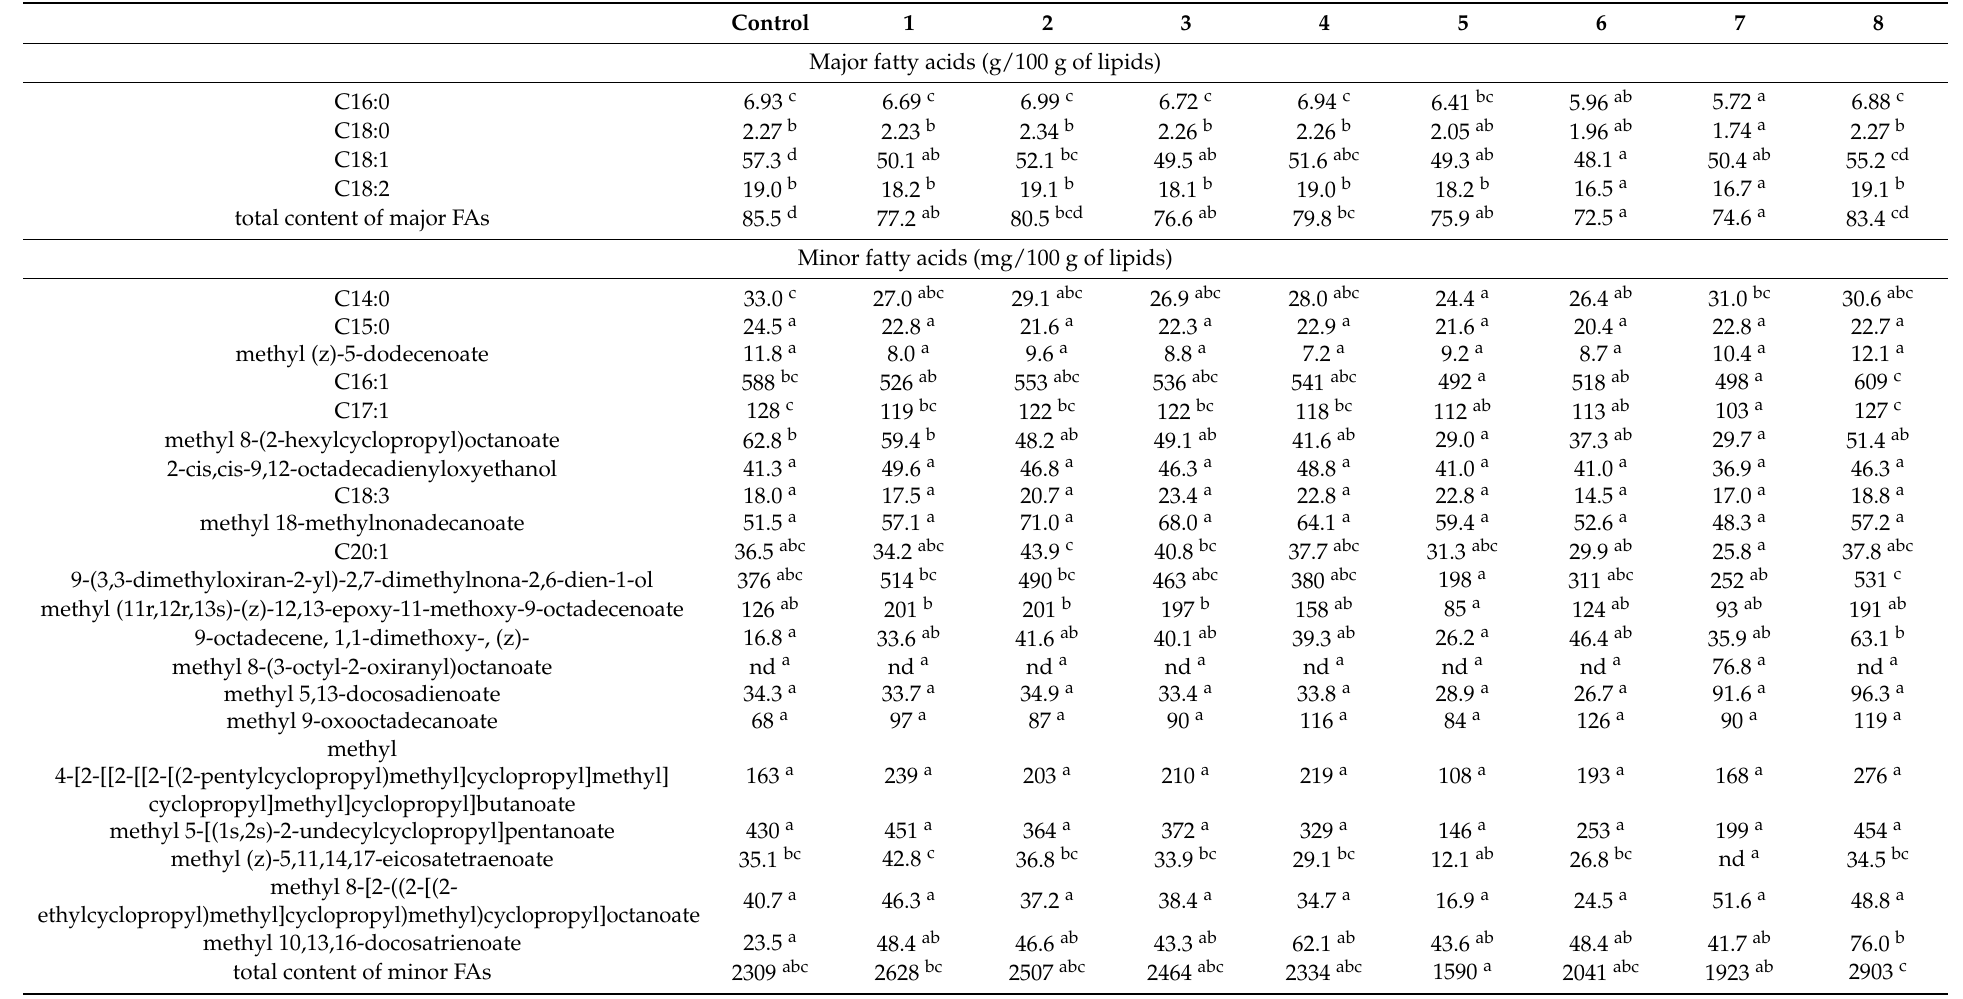
Table 4. Fatty acids content in the control and fermented (48 h) almond